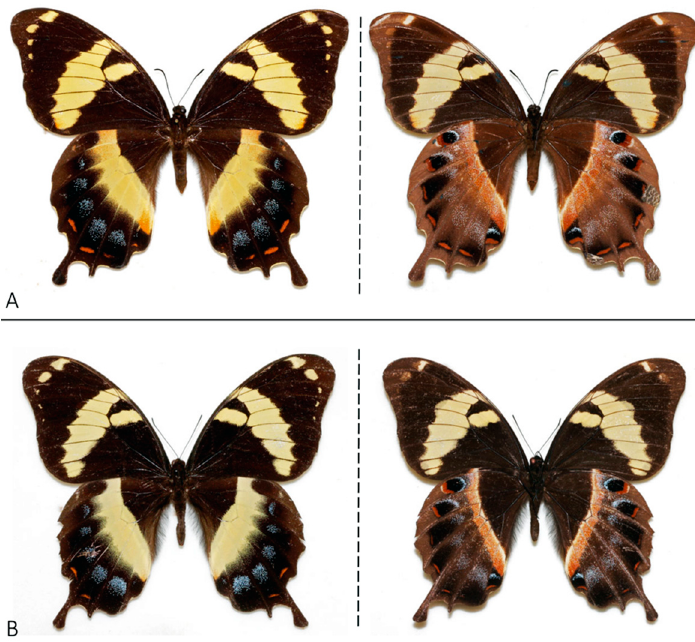
Figure 1. Photographs of representative Papilio homerus from the eastern population. ( A ) Female of P. homerus (dorsal on left, ventral on right) collected from the Blue Mountains, Jamaica (1959). ( B ) Male of P. homerus collected at Corn Puss Gap, Jamaica (1986). All photographs are used with permission from Warren et al. (2016) and acquired from http://butterfliesofamerica.com/L/t/Pterourus_homerus_a.htm.